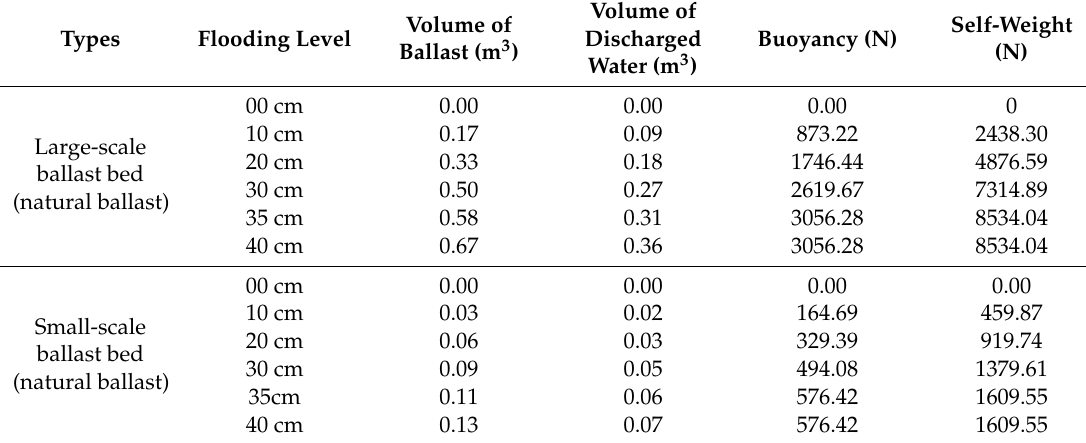
Table 7. The water buoyancy by di ff erent materials and containers.